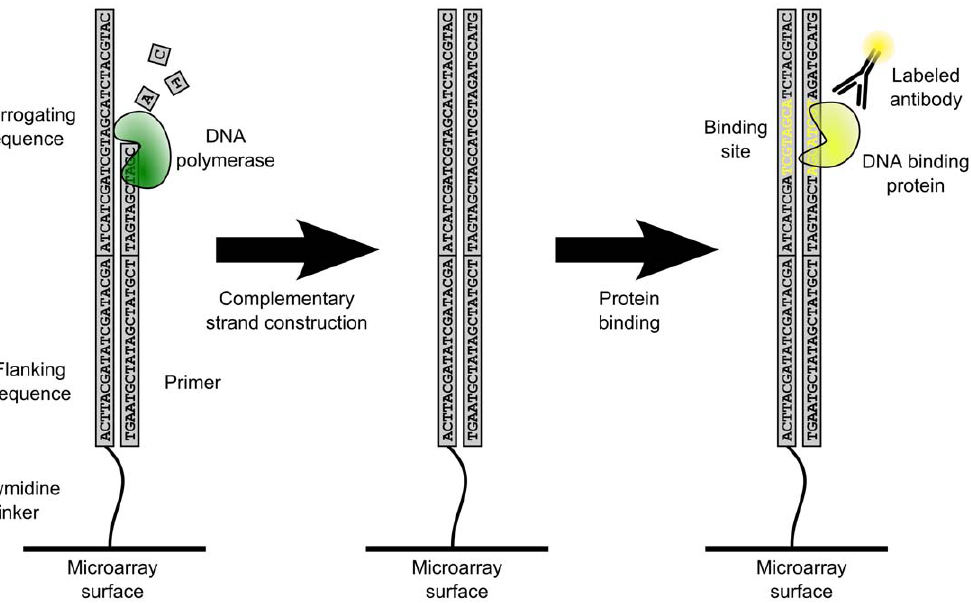
Figure 1. Overview of a PBM array experiment. PBM arrays are constructed by taking a normal oligonucleotide microarray and constructing a complementary strand for each probe using DNA polymerase. Probe-invariant flanking sequences are used as complementary targets for the polymerase primer. Antibody-labeled DNA binding protein is then allowed to bind to probes on the microarray slide, according to the protein’s sequence binding preferences.